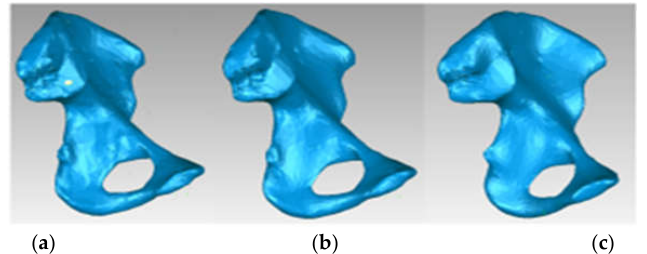
Figure 24. “Decimation” and “finishing” stages applied in Geomagic ( a ) “decimation”; ( b ) first “finishing” stage; and ( c ) last “finishing” stage—final model.